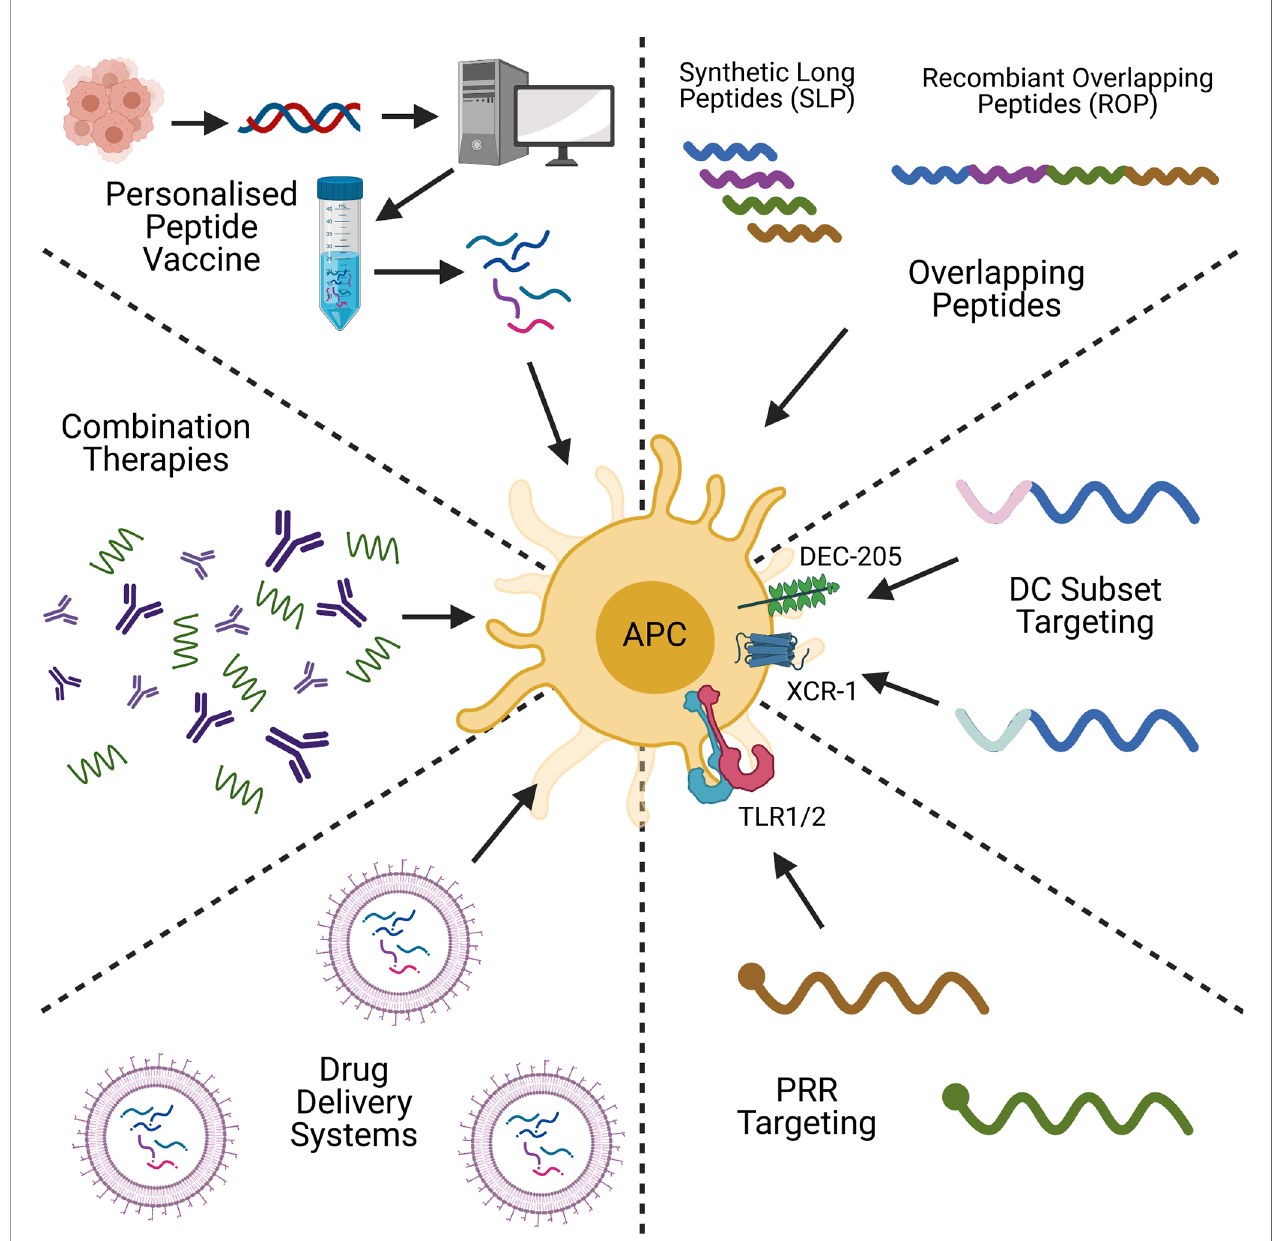
FIGURE 1 | A graphical summary of some of the key concepts in peptide-based cancer vaccine research. Created with